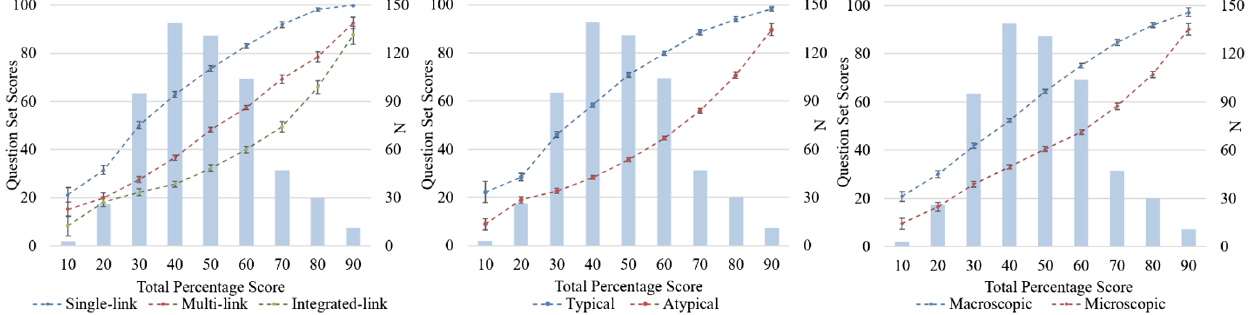
FIG. 2. Distribution of scores on question sets designed with different link types, typical vs atypical contexts, and macroscopic vs microscopic models from students at different total score. The histogram shows the frequency distribution of the students ’ total score on the